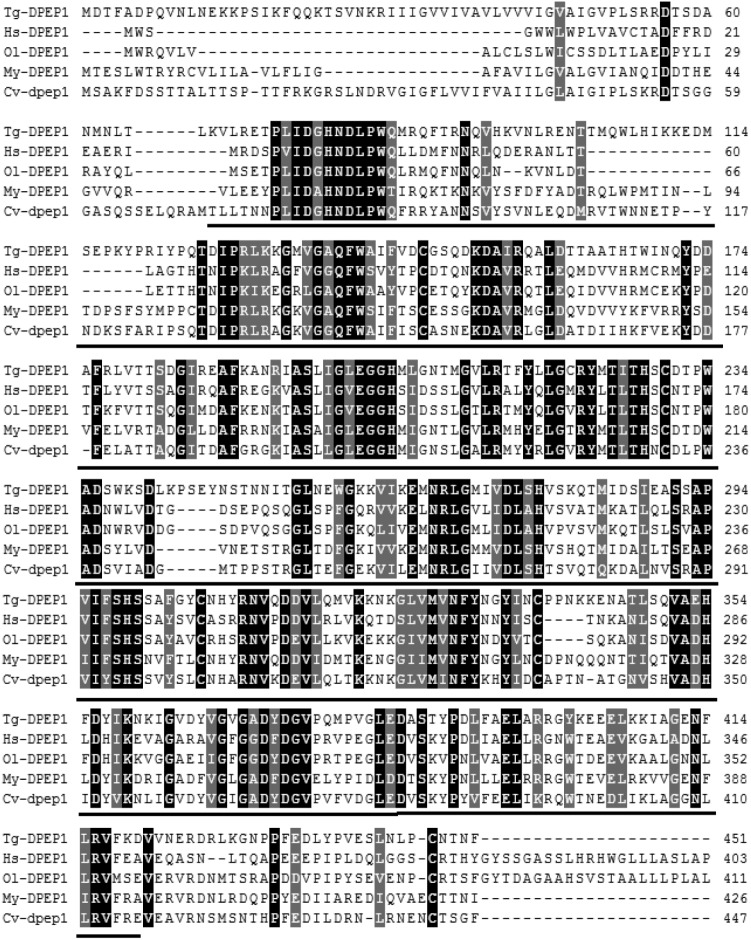
Multiple sequence alignment of DPEP1 from T. granosa (Tg-DPEP1) with other known DPEP1 amino acid sequences: Homo sapiens (Hs, CAG33685.1), Oryzias latipes (Ol, XP_004067177.1), Mizuhopecten yessoensis (My, XP_021371422.1), and Crassostrea virginica (Cv, XP_022307112.1). Identities are shaded dark, and similarities are shaded gray. The DPEP1 domain regions are underlined.